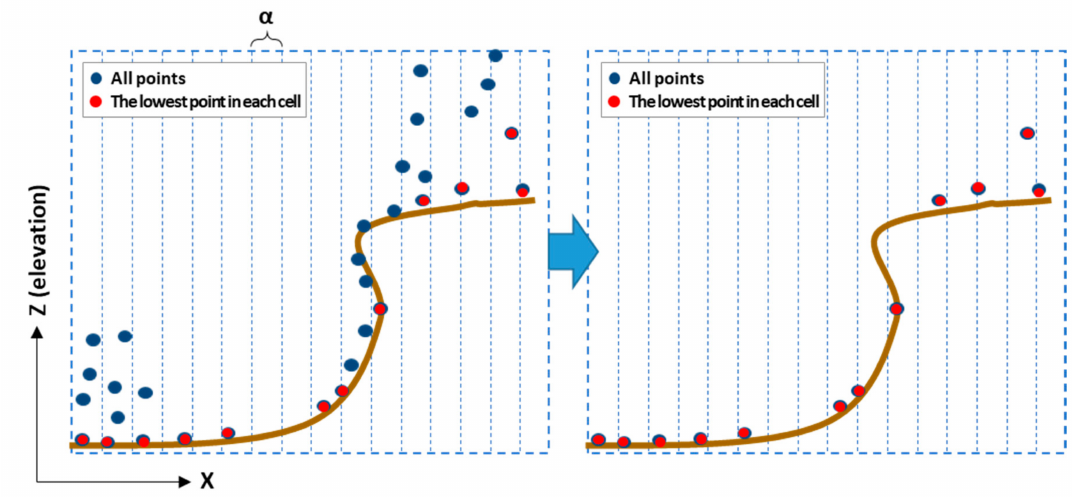
Figure 5. Extracting the lowest point in each grid ( α × α spacing on X-Y